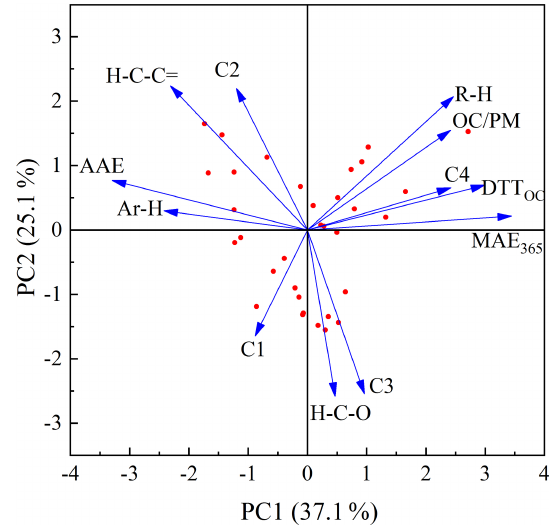
Figure 7. Principal component analysis results for the carbon mass- normalized OP activities and chemical characteristics of BrC com- pounds in smoke